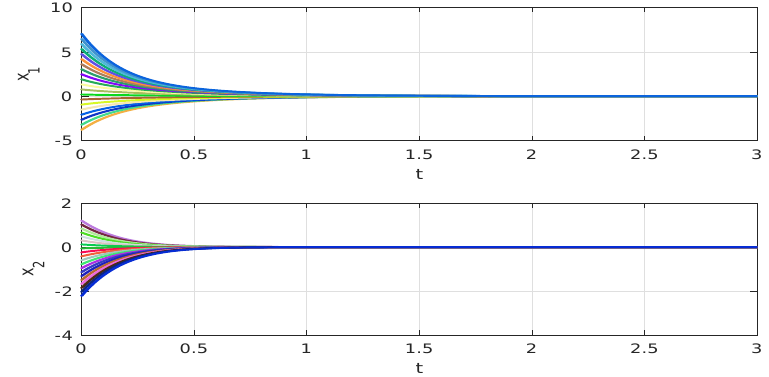
Figure 12. An illustration of the time responses with respect to the real parts pertaining to the model in (20), in which ˜ u ( t ) = 0 in Example 3.